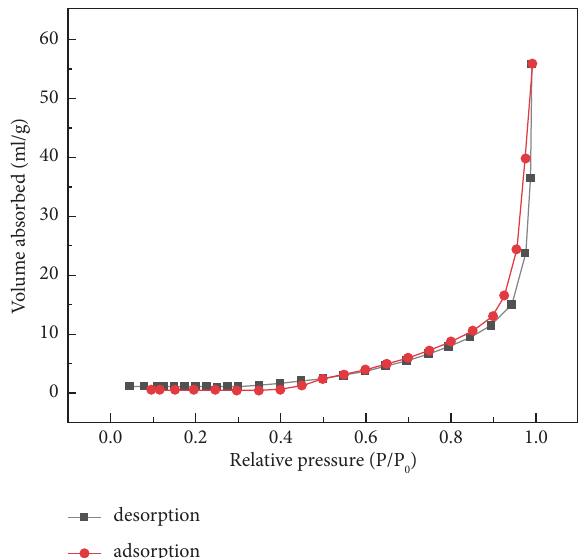
� 1 :1, hydrothermal time: 24h, Mg-Ca-Al HTLCs